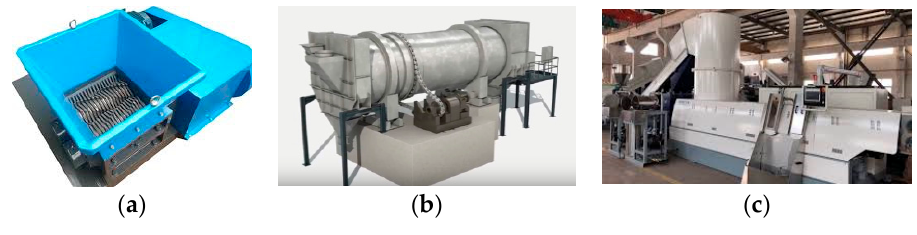
Figure 4. ( a ) Grinding plant; ( b ) Rotary dryer; ( c ) Pelletizer.